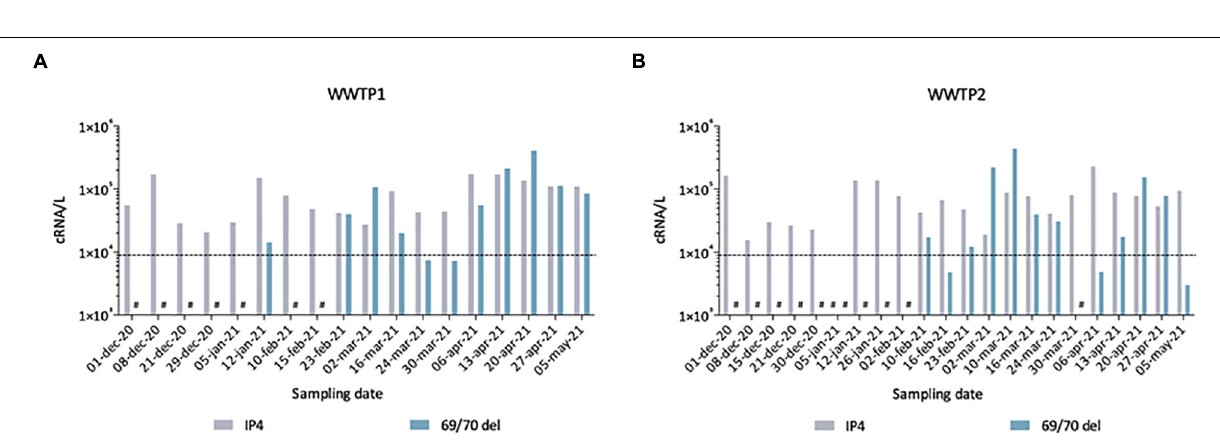
Frontiers in Microbiology |